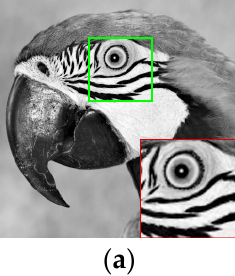
Figure 4. The denoising process of our algorithm. ( a ) Original image. ( b ) Noise image ( σ 3 ( σ s = 9.0 × 10 − 2 , σ r = 3 × 10 − 1 )). ( c ) The preliminary image. ( d ) The final image.